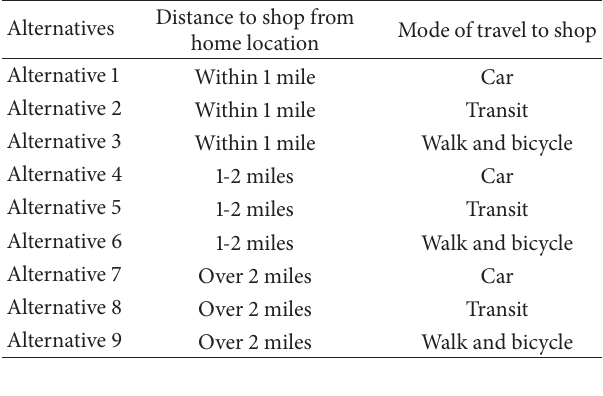
Table 1: Alternatives for joint choice of shopping destination and travel-to-shop mode.